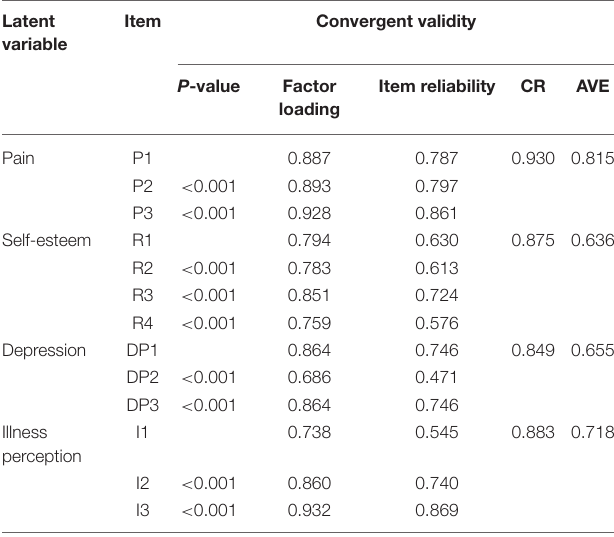
TABLE 3 | Reliability and validity of instruments for assessment of pain, illness perception, self-esteem, and depression ( n = 326). Latent